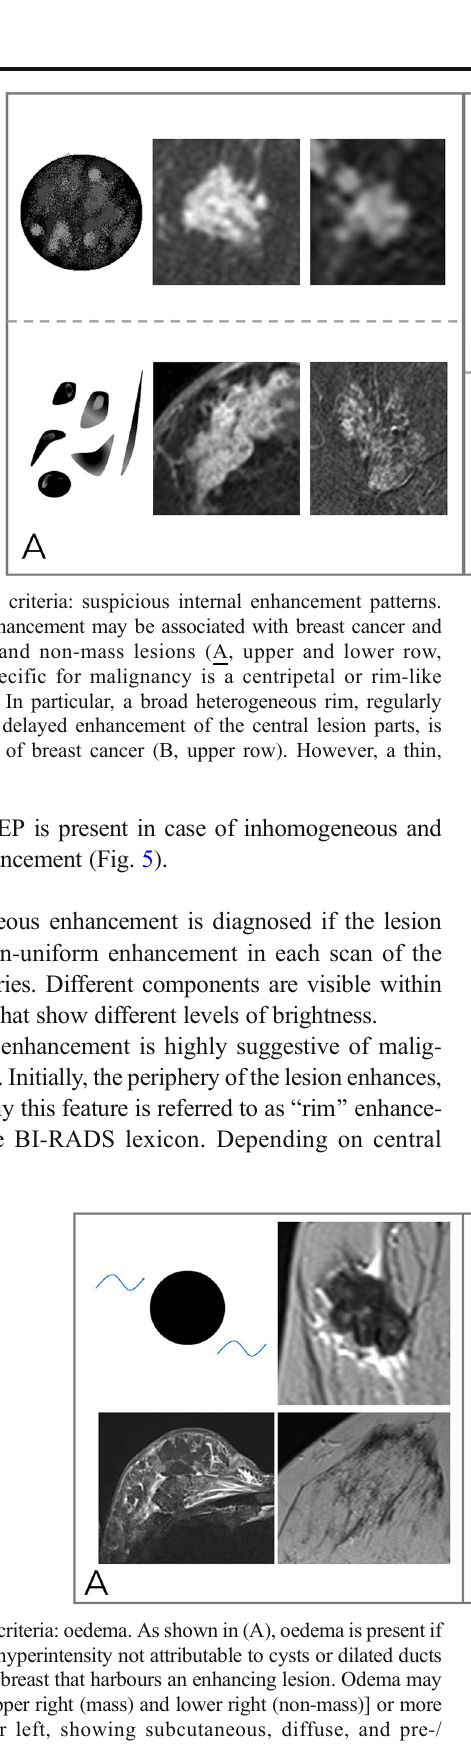
intrapectoral oedema in an inflammatory breast cancer case with distinct lymphangiosis). B: Absent oedema. The common pitfall causing false- positive oedema assessment is chemical shift artefacts in sharp fat-water interfaces, such as that caused by vessels (e.g., B upper right, lower right) and capsulated fibroadenomas at the parenchyma-fat